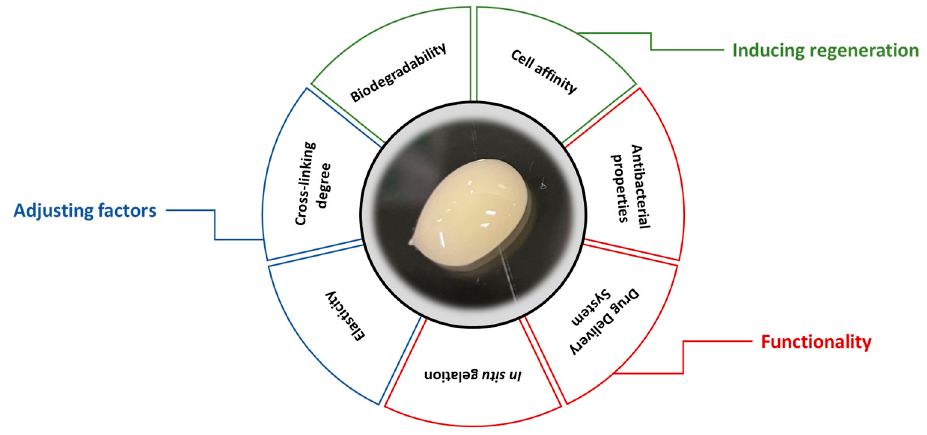
Figure 1. Requirements for ideal hydrogels.